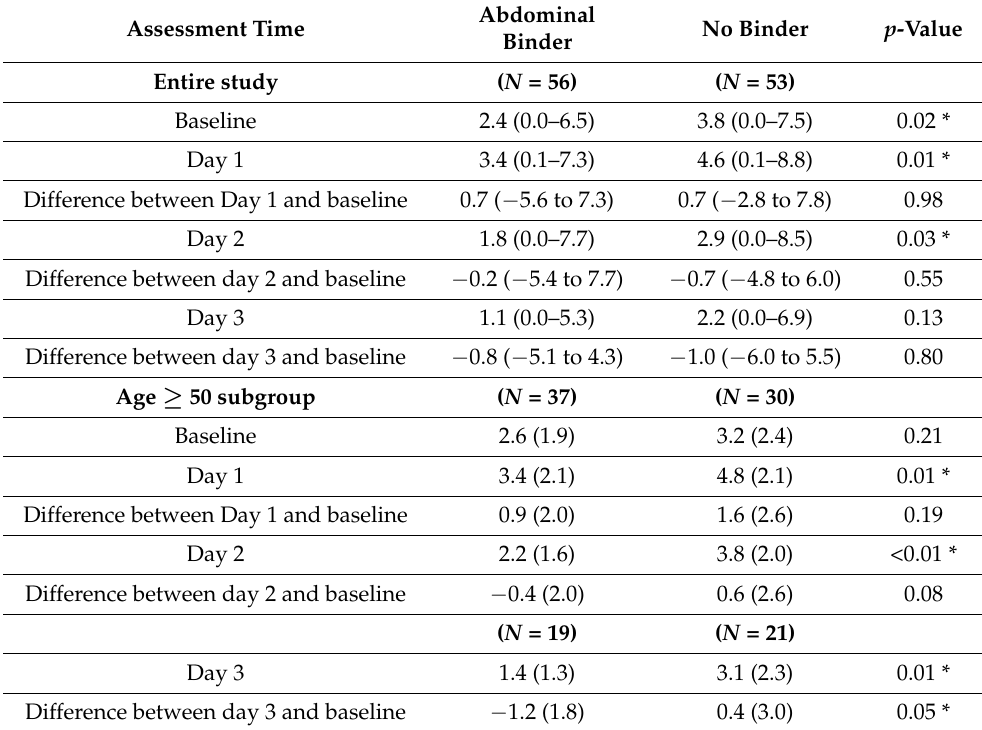
Table 2. Postoperative pain scores.